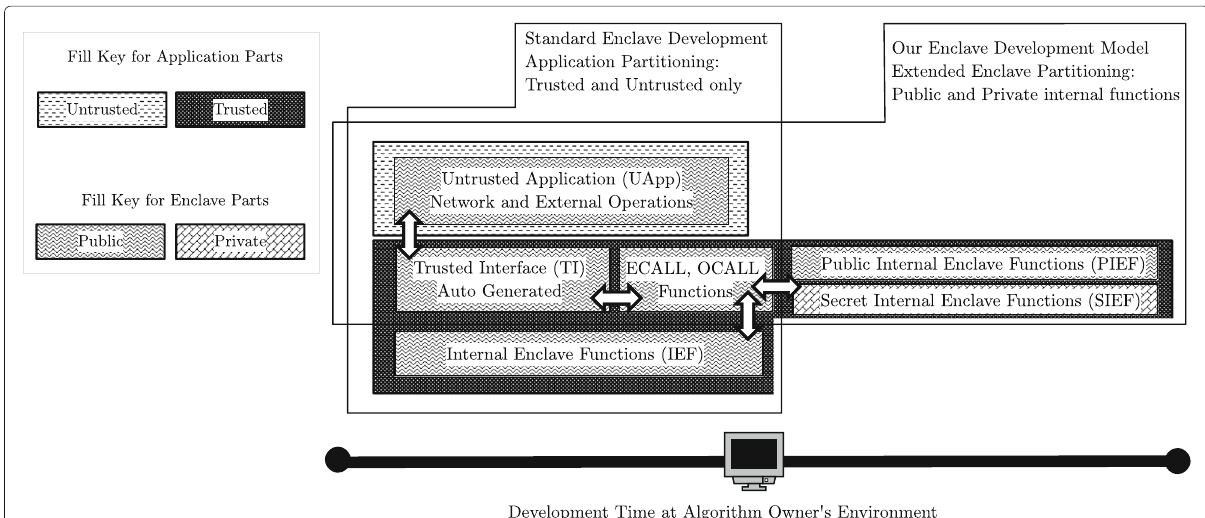
Fig. 6 Extending the Enclave development model with Private and Public parts. In addition to the application partitioning into trusted and untrusted, we introduce the enclavepartitioning for internal functions. These functions never communicate directly with the outside